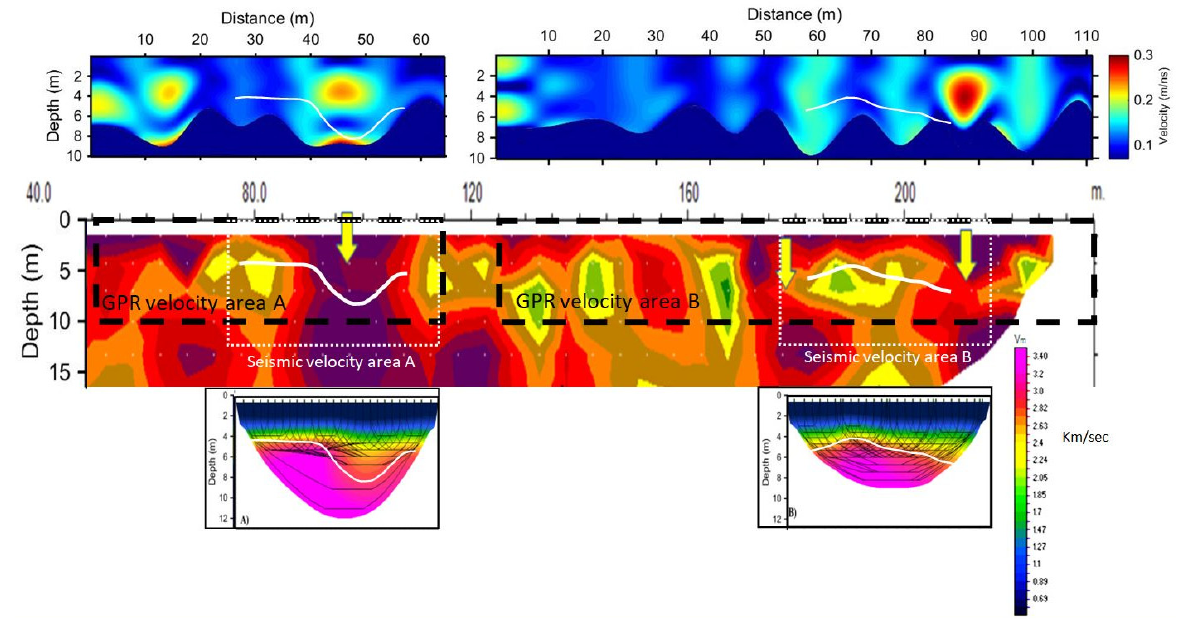
Figure 10. GPR velocity attribute calibration based on the response of the other methods over the known cave (90–105 m horizontal distance in the ERT section) and the overlaid low compaction formation (under the first yellow arrow from the left). ERT resistivity values follow the same color scale as in Figure 4. The whole image is utilized for the integrated interpretation section. White lines indicate seismic velocities around 2800 m/ns in the seismic velocity sections and are also superimposed to the other Methods sections for comparison. All other yellow arrows than the first, indicate high resistivity anomalies initially attributed to high-risk zones. All images are also depicted separately in Figures 4, 6, and 9.